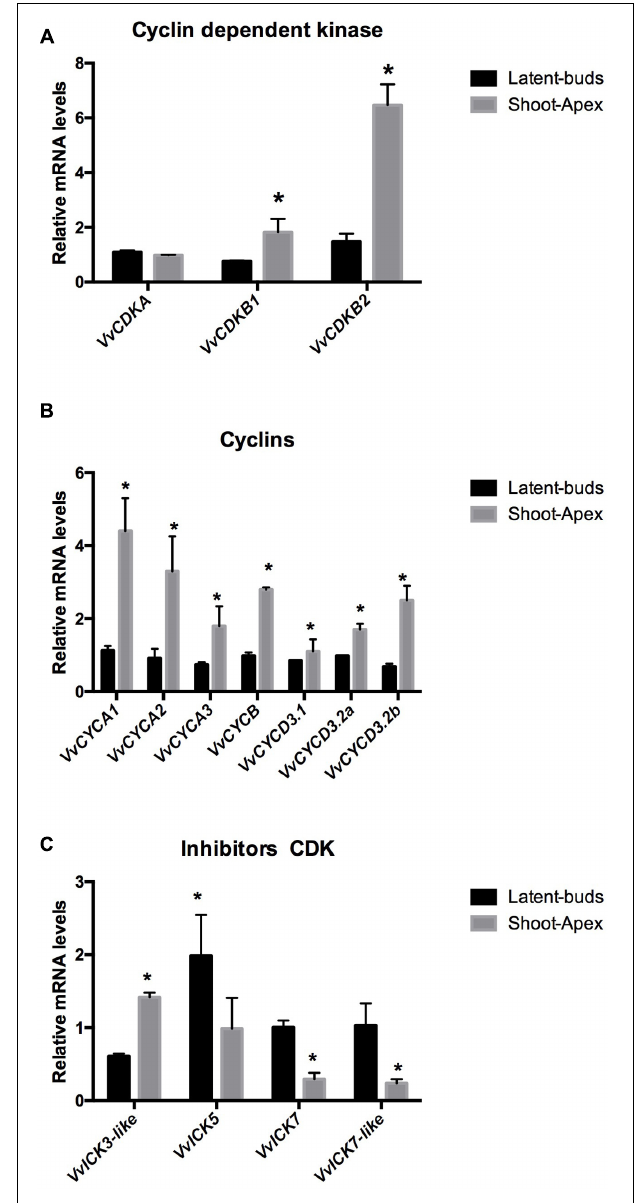
FIGURE 2 | Difference in gene expression of (A) cyclin-dependent kinases ( VvCDKs ), (B) cyclins ( VvCYCs ), and (C) inhibitors of CDKs ( VvICKs ) in latent buds and shoot apexes. Gene expression analysis was performed by RT-qPCR and normalized against VvUBIQUITIN . Values are the average of three biological replicates with three technical repetitions ± SD; (asterisk) Student’s t -test ( α =